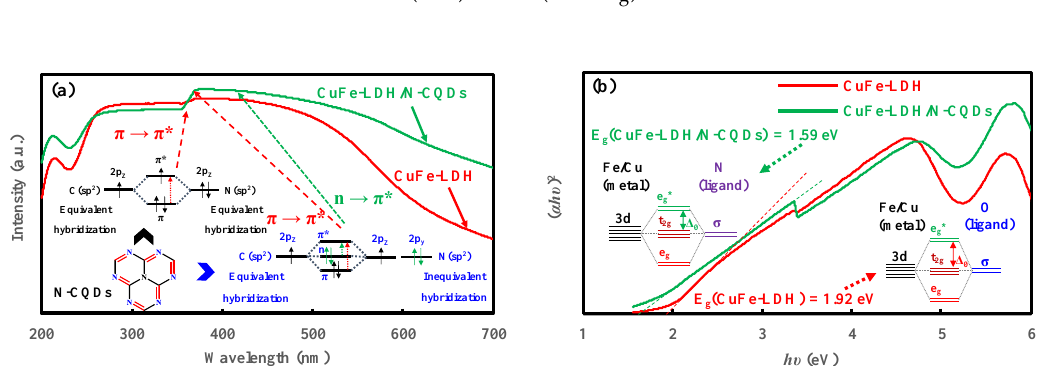
Figure 9. UV-vis diffuse reflectance (DRS) ( a ) and calculated band gap (E g ) ( b ) for CuFe-LDH and CuFe-LDH/N-CQDs.